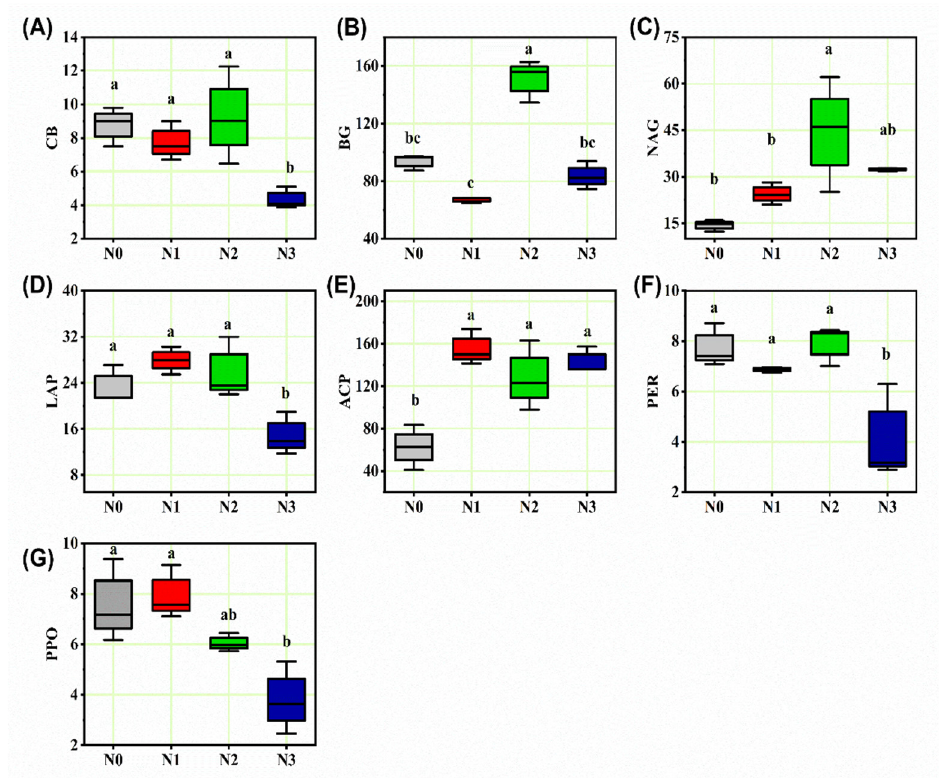
Figure 1. Activities of soil β -1,4-glucosidase (( A ), BG), cellobiohydrolase (( B ), CB), β -1,4-N-acetyl- glucosaminidase (( C ), NAG), leucine aminopeptidase (( D ), LAP), acid phosphatase (( E ), ACP), peroxidase (( F ), PER) and polyphenol oxidase (( G ), PPO) in different N-rate treatments. Different lowercase letters on the boxplot indicate significant differences ( p < 0.05) among treatments.